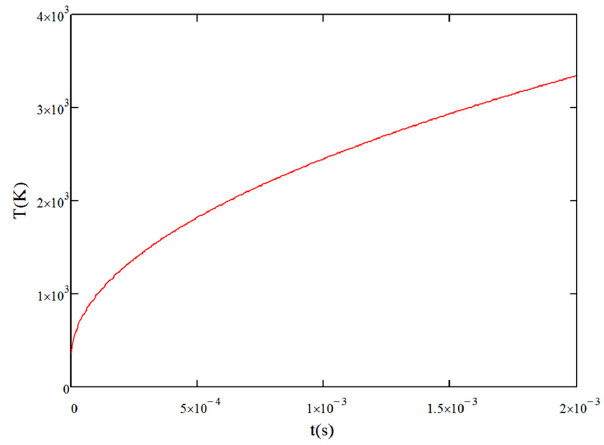
Figure 5. Simulation of AlMg5 surface temperature evolution during irradiation with a laser pulse of